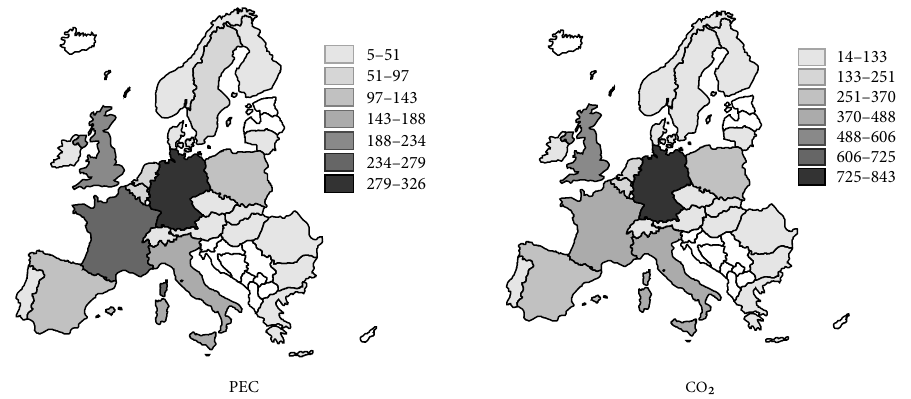
in million tonnes 2